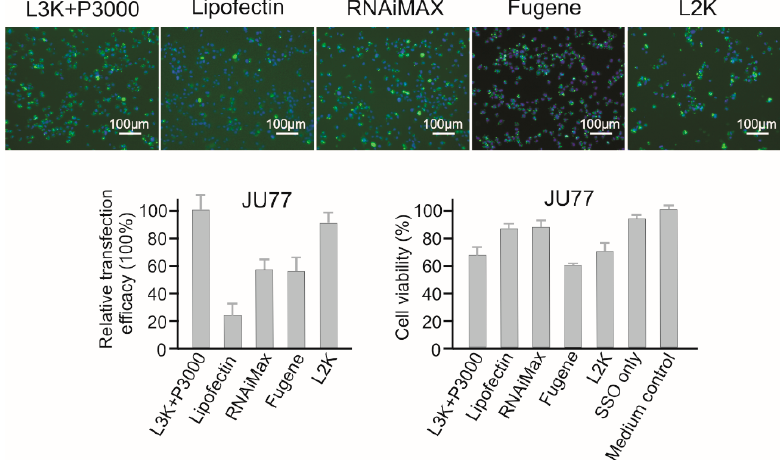
Figure 6. In vitro transfection efficiency and cytotoxicity of different transfection reagents in JU77 cells. L3K: Lipofectamine 3000, L2K: Lipofectamine 2000.